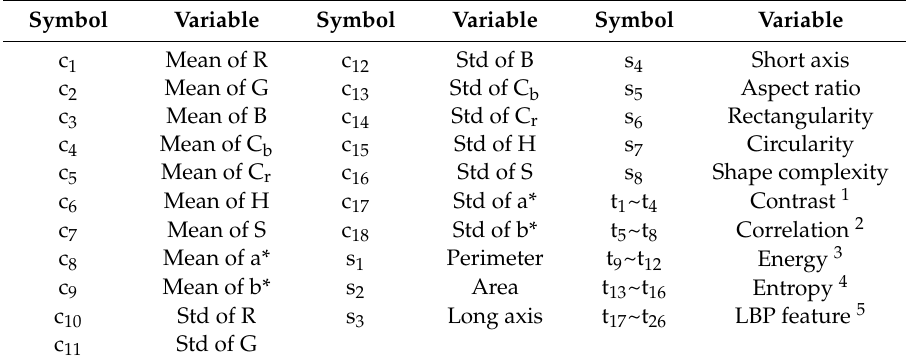
Table 1. Optical feature variables of sweet corn